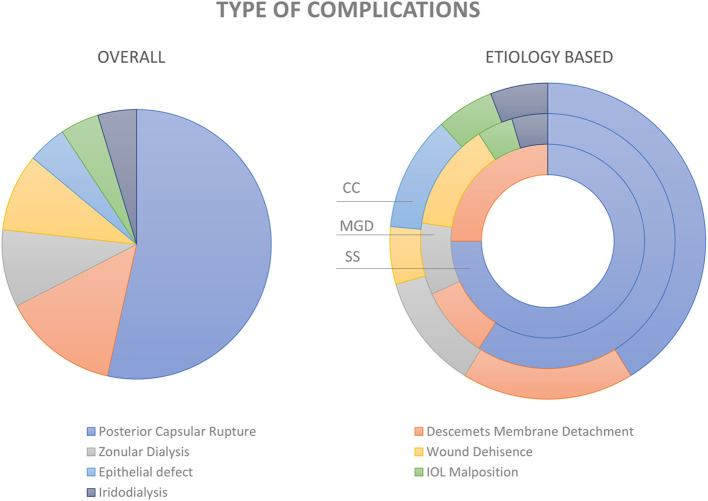
Complications of cataract surgery in dry eye disease. Pie diagram showing the distribution of various types of complications in the entire study cohort (image on the left). The distribution within the groups; i.e., cicatrizing conjunctivitis (CC), meibomian gland dysfunction (MGD), and Sjogren's syndrome (SS) are depicted in the donut graph (image to the right).